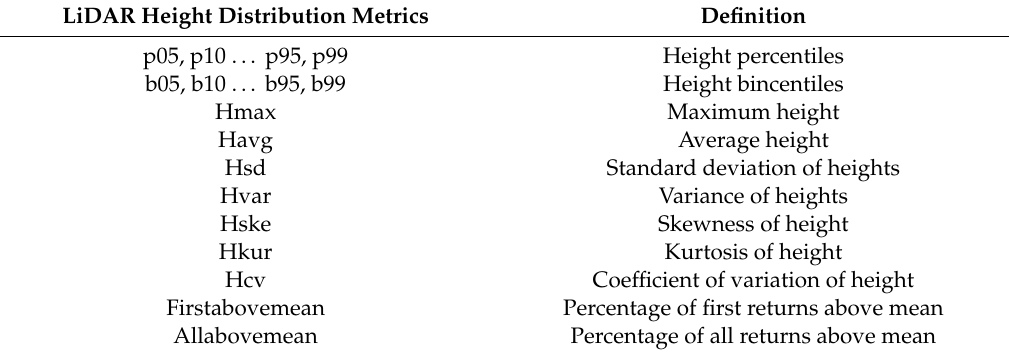
Table 2. The LiDAR-derived height distribution metrics calculated for the surface fuel load (SFL) estimation. All described metrics were computed for the first-of-many (fm), last-of-many (lm), single (s), and all